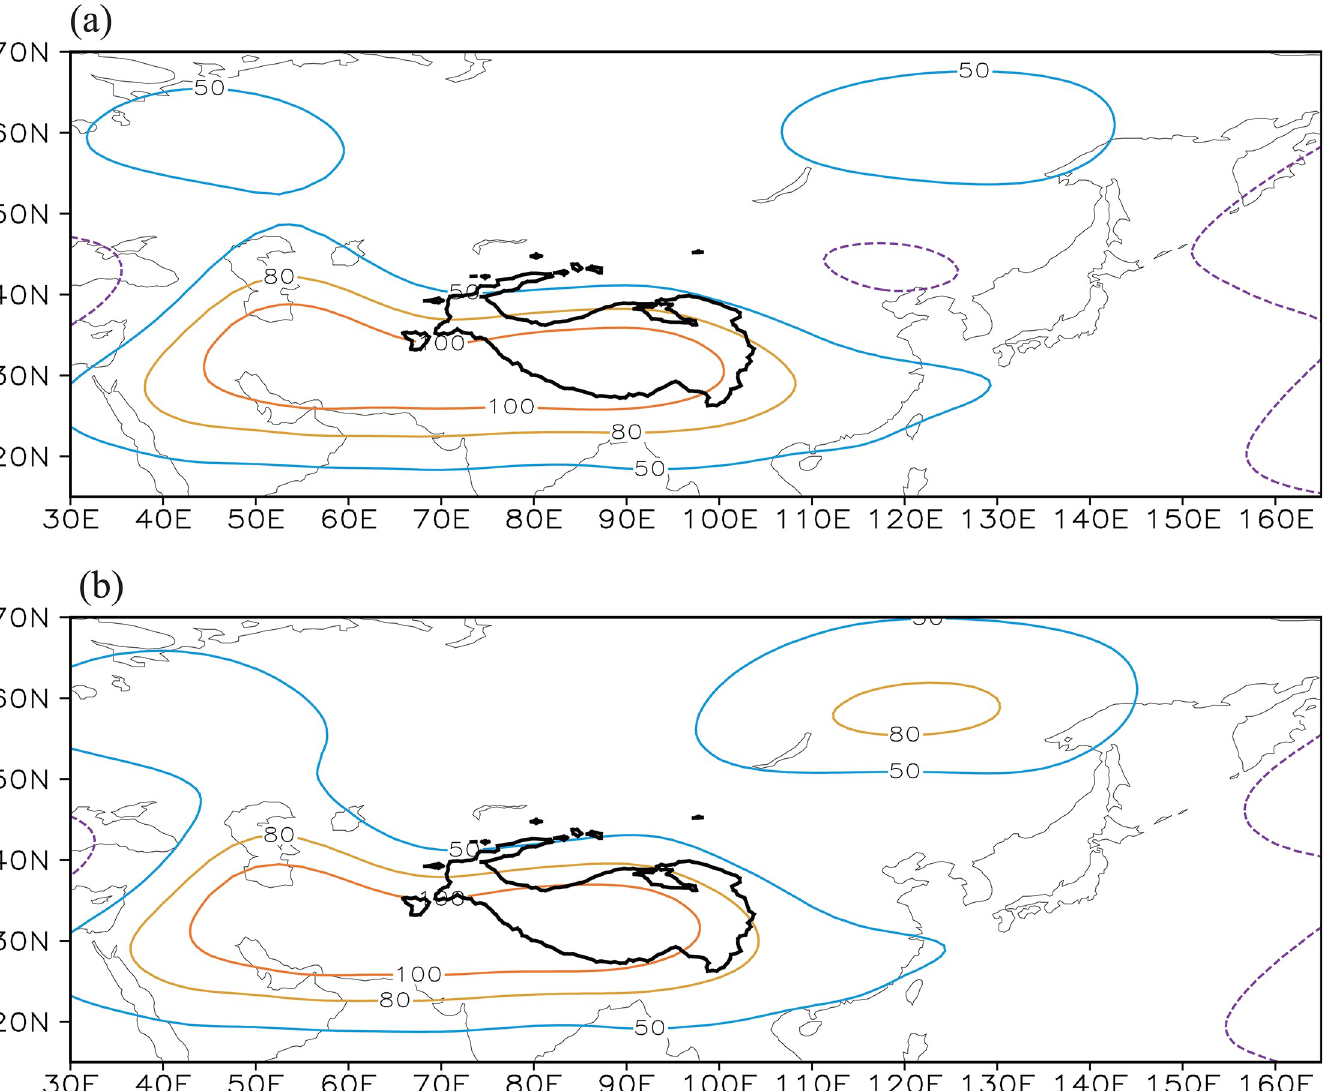
Fig 6. (a) Spatial distribution of the climatological mean summer eddy 200 hPa geopotential height (units: gpm) during the time period 1982–2014. (b) Spatial distribution of the climatological eddy 200 hPa geopotential height after superimposition by the geopotential height anomalies regressed on the Tibetan Plateau–Lake Baikal dipole index (i.e., the principal component of EOF2). The black solid contour denotes the Tibetan Plateau ( > 3000 m).